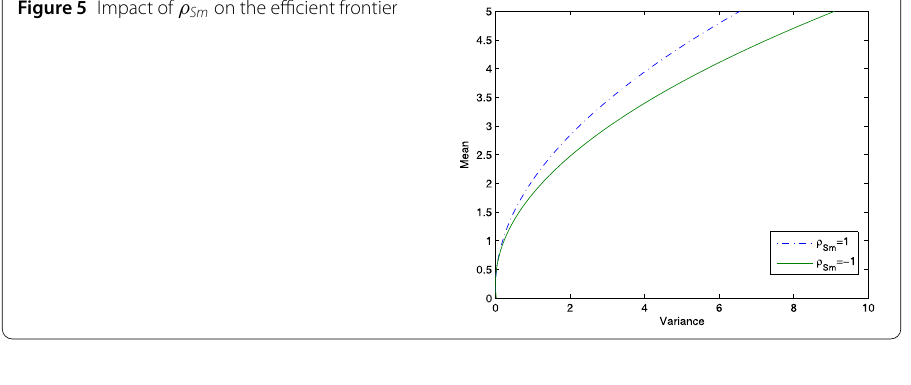
Figure 6 Impact of λ 2 on the efficient